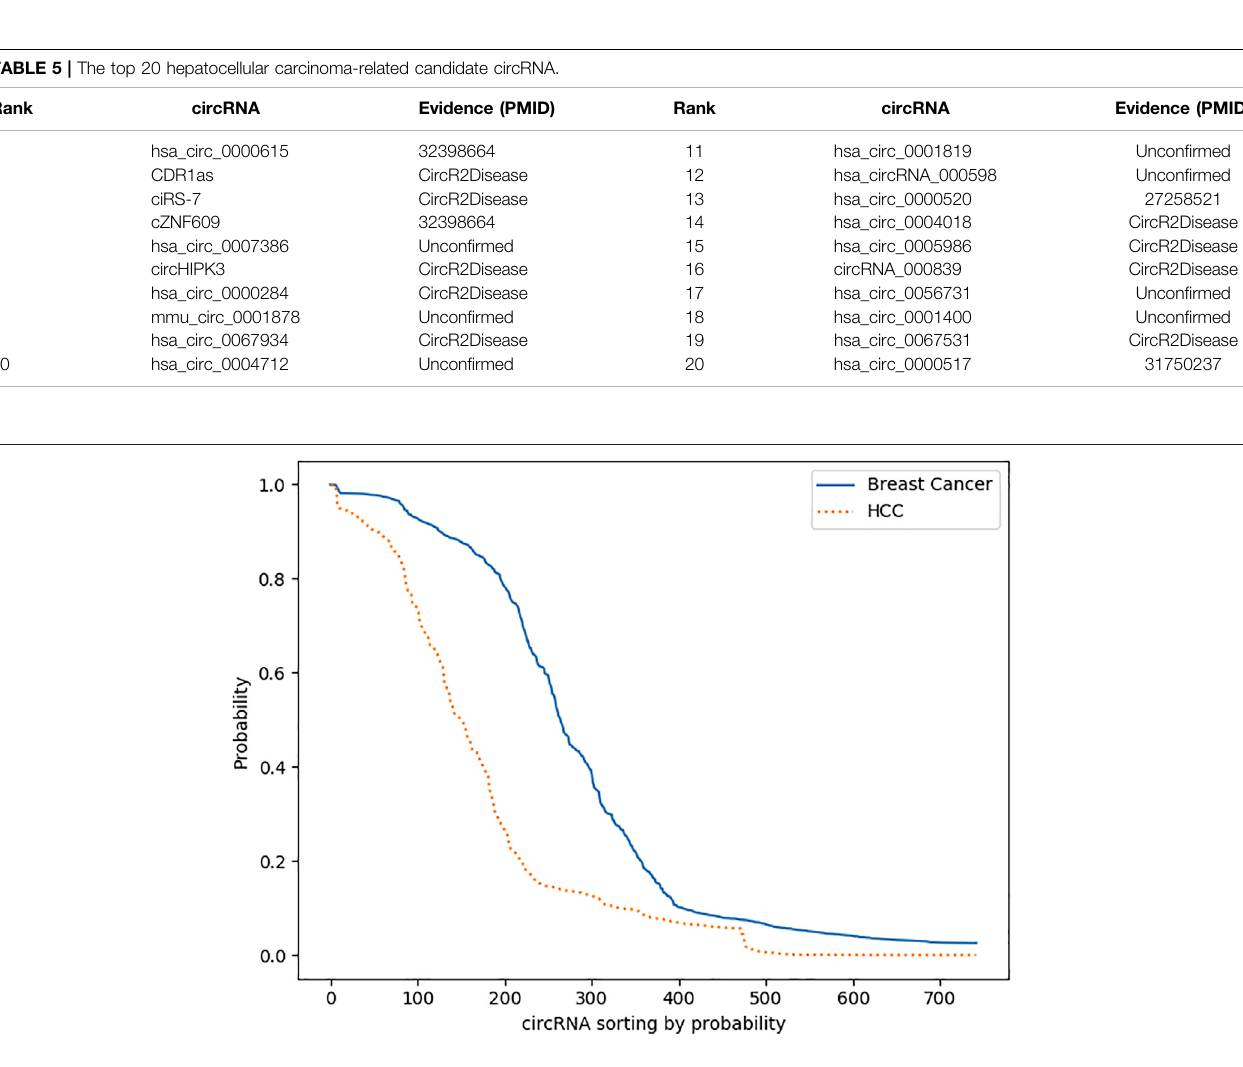
Frontiers in Genetics |